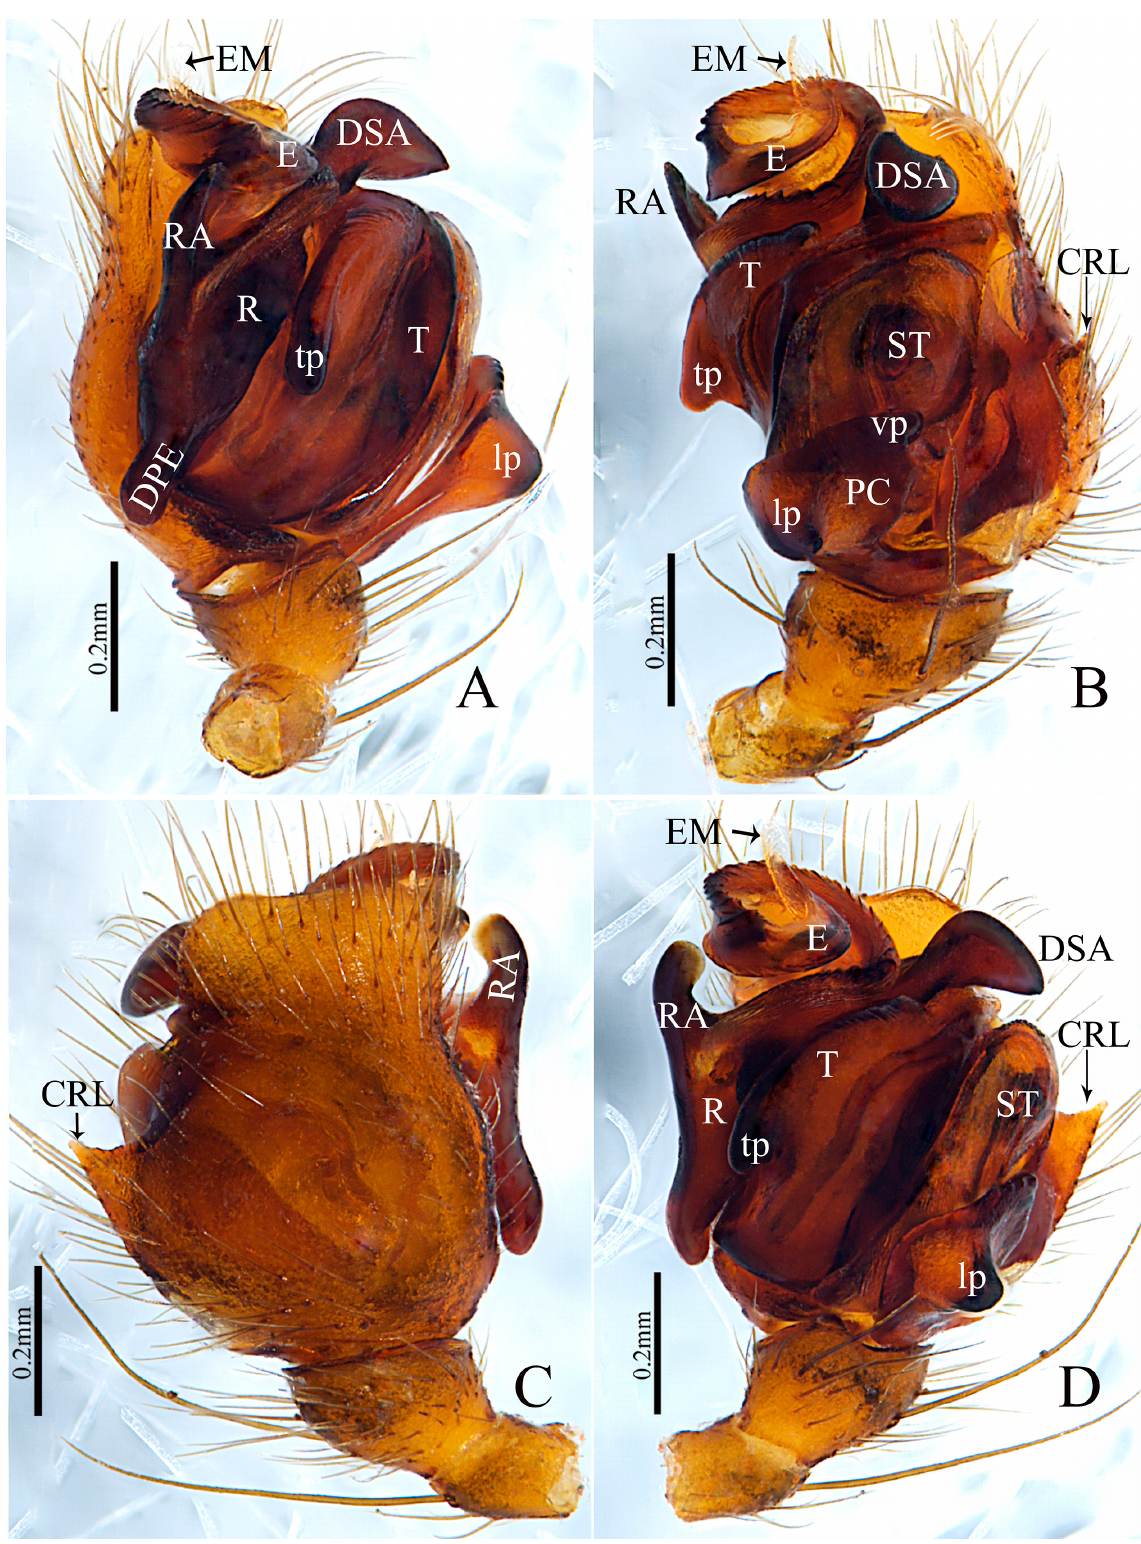
Fig. 15. Acroterius circinatus gen. et sp. nov., ♂, holotype (HNU-CGY137), palp. A . Prolateral view. B . Retrolateral view. C . Dorsal view. D .